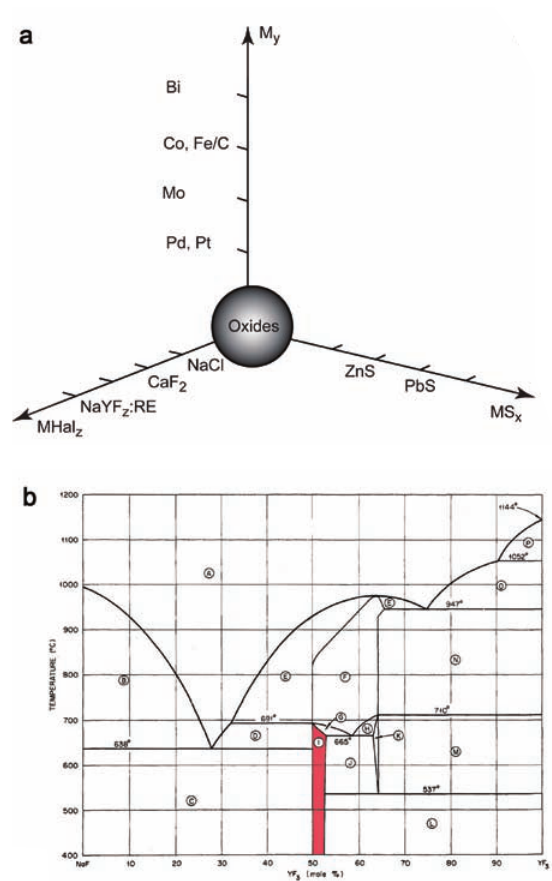
Fig. 1 (a) Schematic representation of various nano- structures currently available by the flame- pyrolysis technique and (b) phase diagram of the NaF-YF system (Thoma et al., 1963). The 3 shaded area marks the hexagonal NaYF stabili- 4 ty region. Adapted with permission from Thoma et al., 1963. Copyright 1963 American Chemical